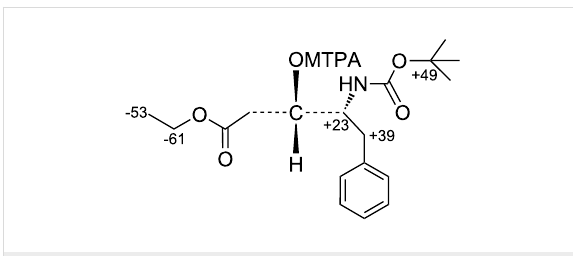
Figure 2: Δδ = ( δ S −δ R ) × 10 3 for ( S )- and ( R )-MTPA esters of com- pound 8b